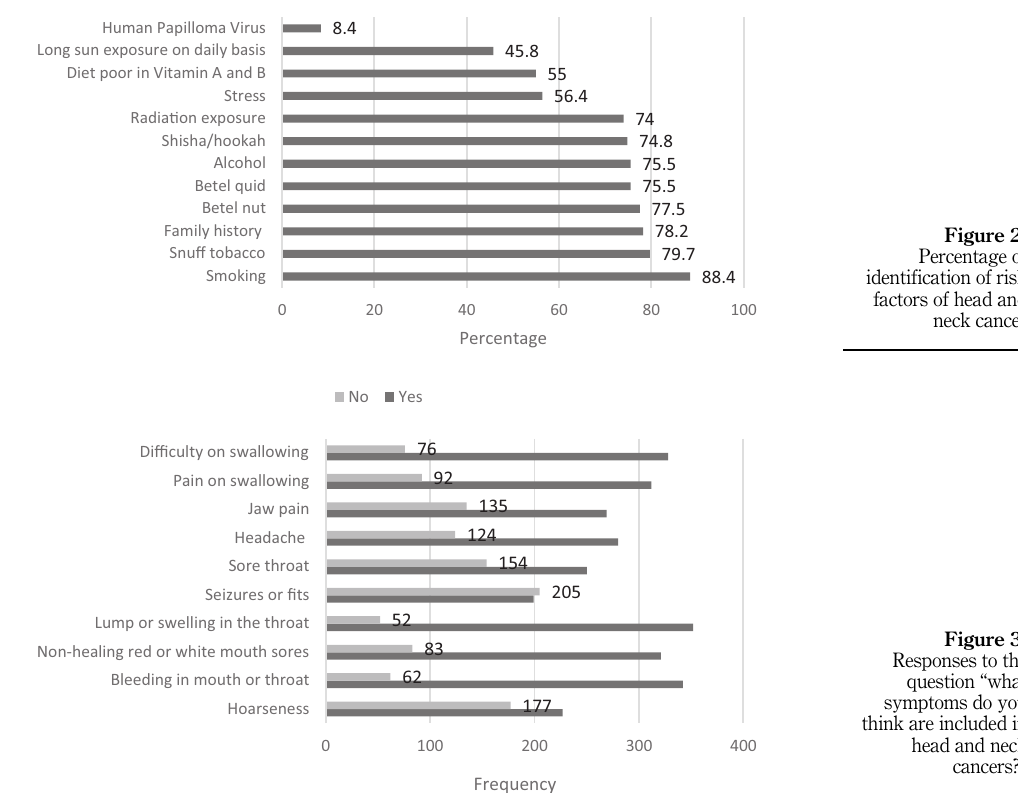
Figure 3. Responses to the question “ what symptoms do you think are included in head and